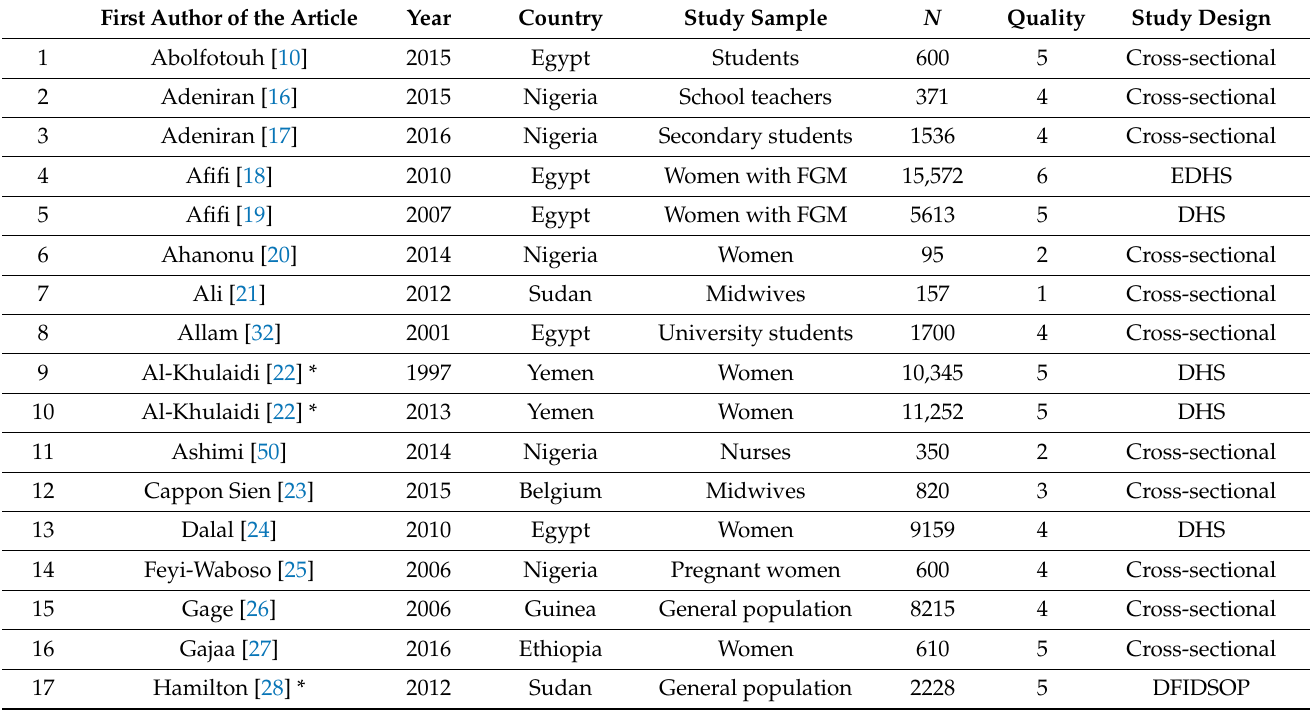
Table 1. Descriptive statistics of the included studies ( n =